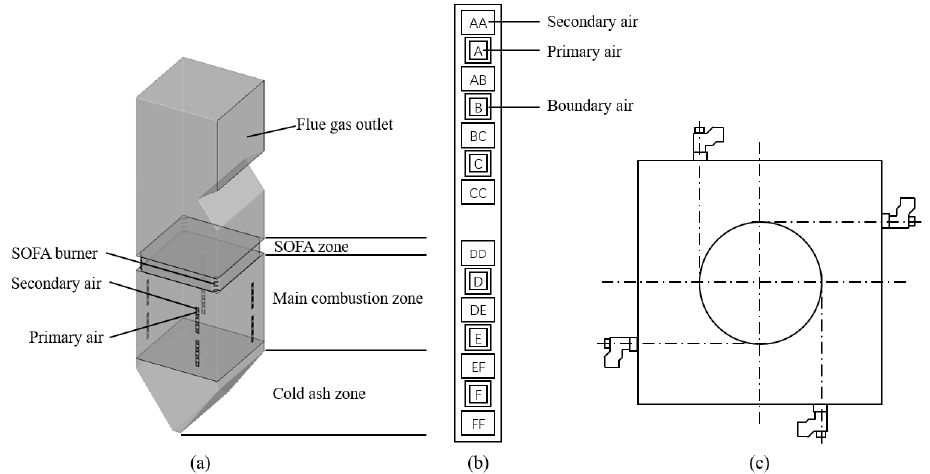
Figure 1. Furnace structure and burner arrangement. ( a ) Furnace structure. ( b ) Burner arrangement. ( c ) Cross-section of main combustion zone.